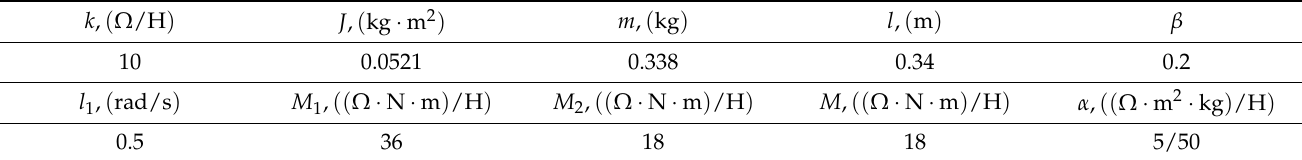
Table 1. The simulation